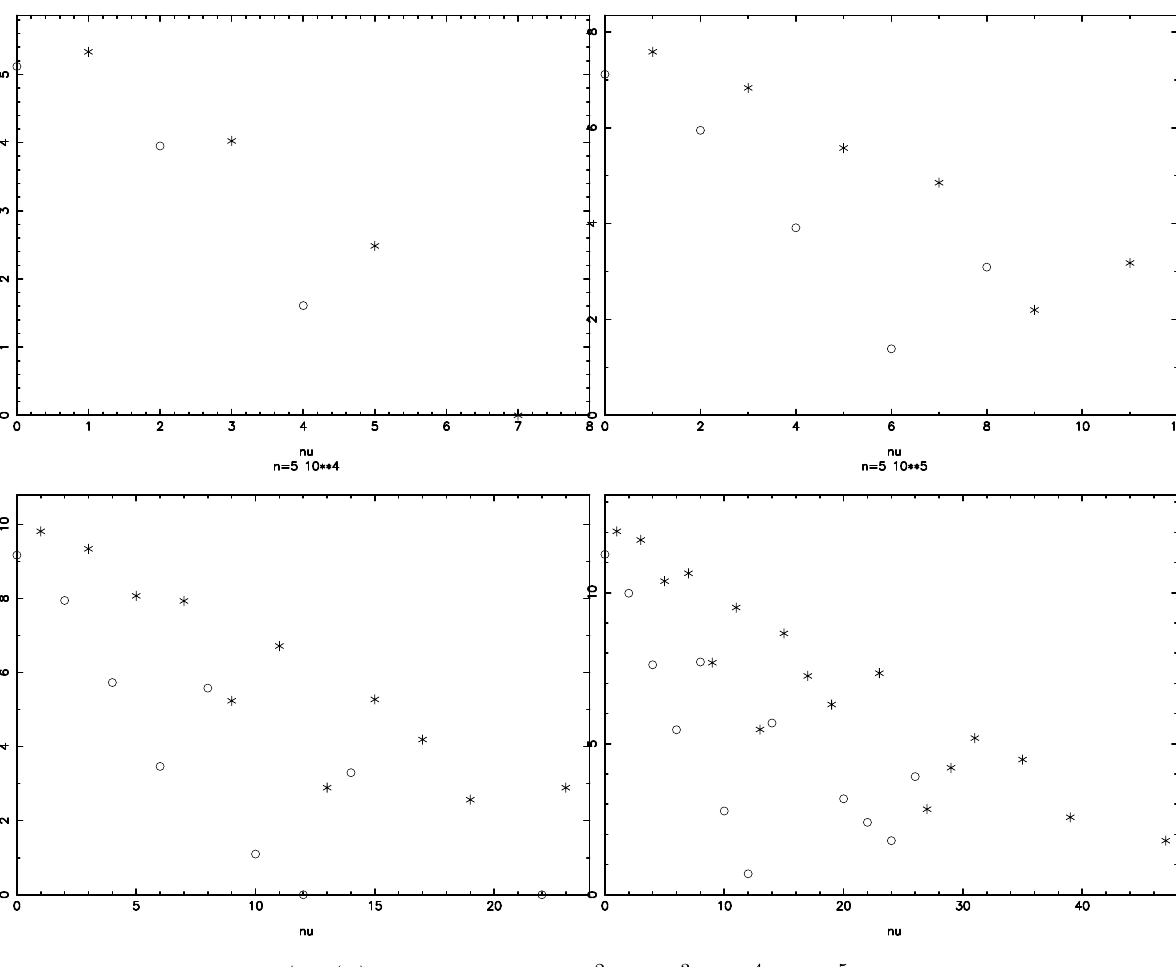
Figure 4: Distributions ln (Π ravens , asterisk: cods